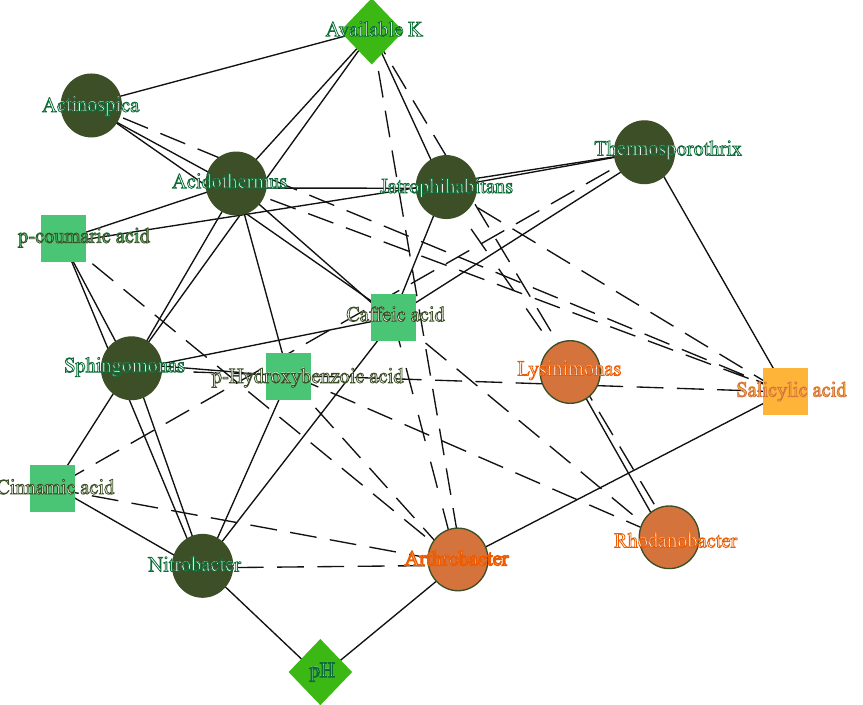
Figure 6. The correlation network of phenolic acids with bacteria and soil physicochemical properties. When the correlation factor is yellow, it means that the factor is enriched in the 10-year post-ginseng rotation soil (RS), whereas when it is green, it represents the soil in which no ginseng was grown (CS) before ginseng planting. The solid line represents the positive correlation among the correlation factors, while the dotted line is the negative correlation. The circle represents bacteria, and the different arrangement of squares represents phenolic acid and physicochemical